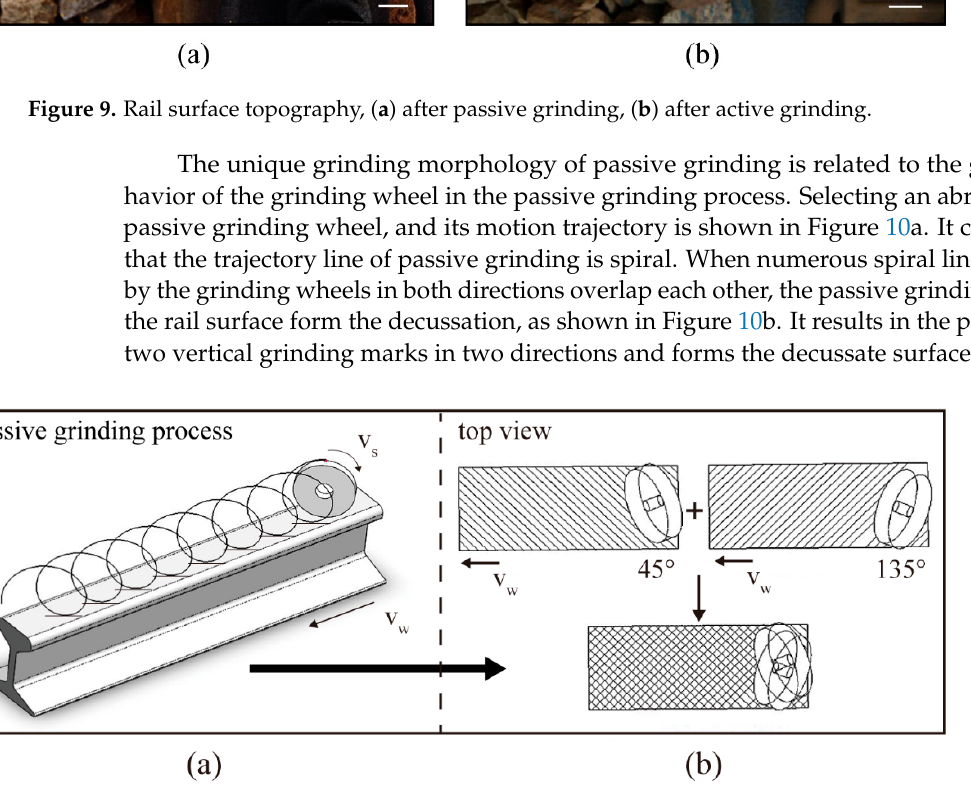
Figure 10. ( a ) Motion trajectory of grinding wheel in passive grinding process, ( b ) grinding marks of passive grinding.